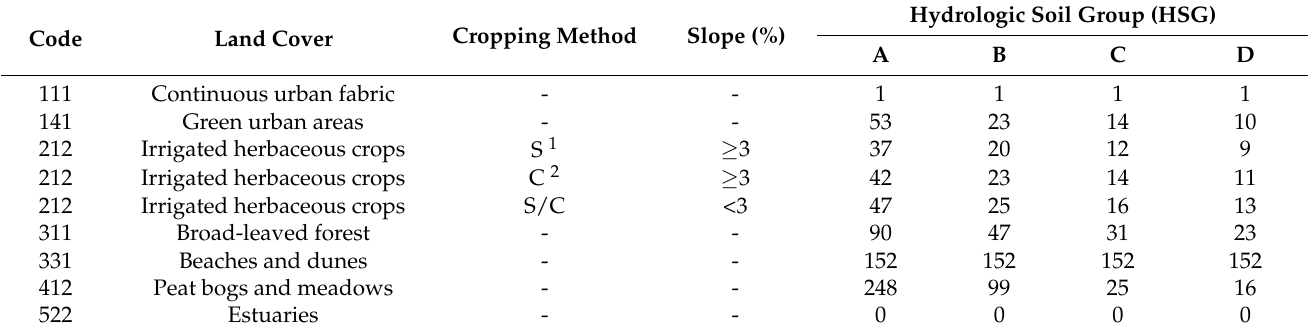
Table 2. Excerpt of the values adopted to determine the runoff threshold ( P 0 ). Adapted from [40].